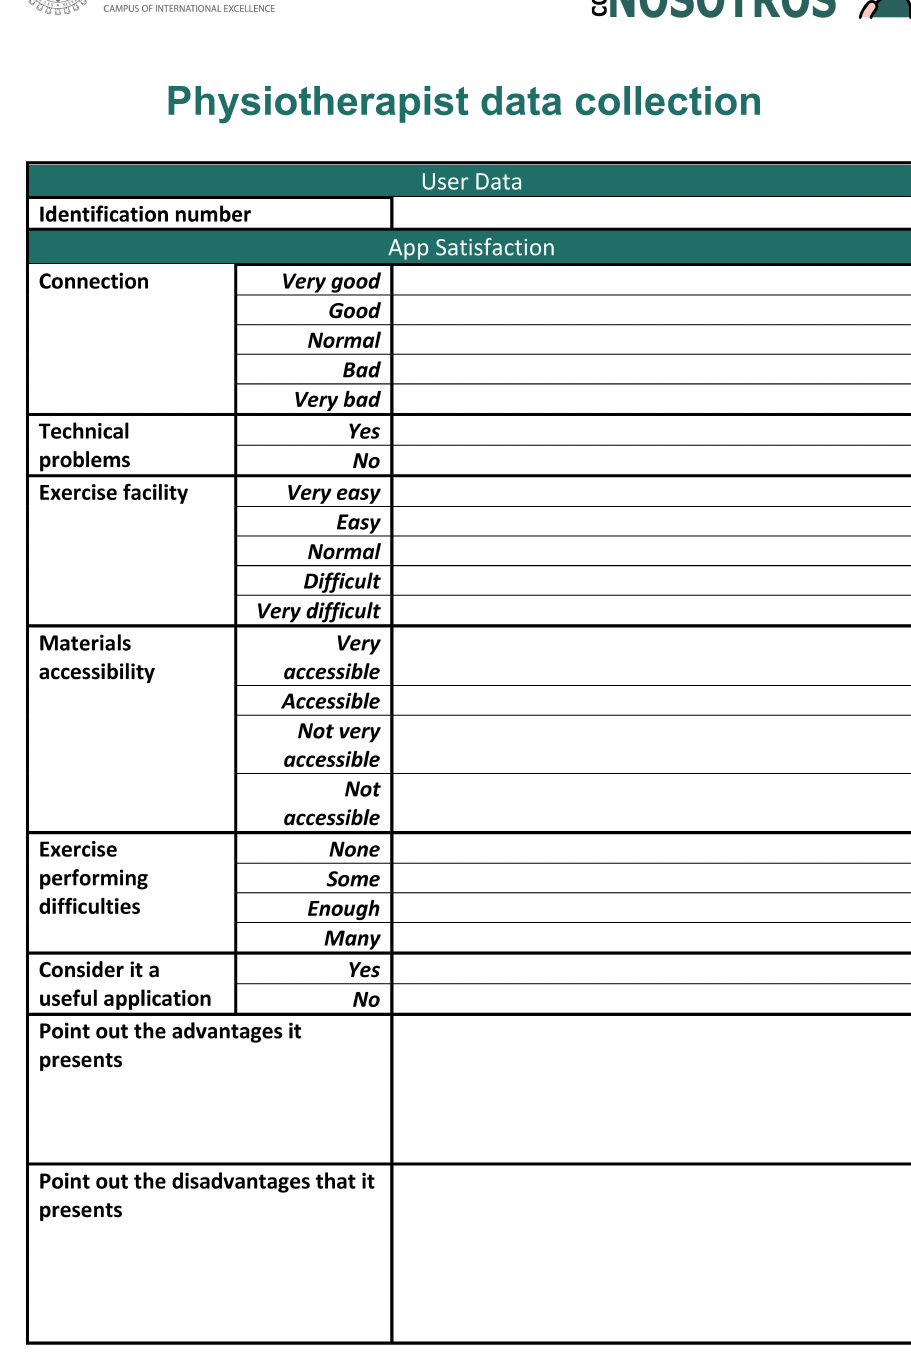
Figure A2. Physiotherapist data collection